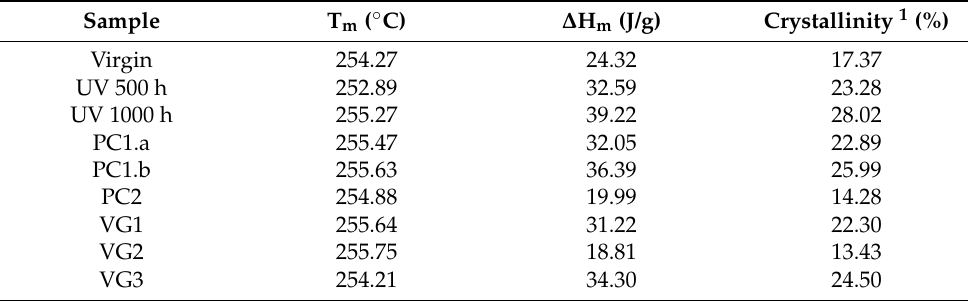
Table 7. Thermal properties of the structural part (SP) samples of the